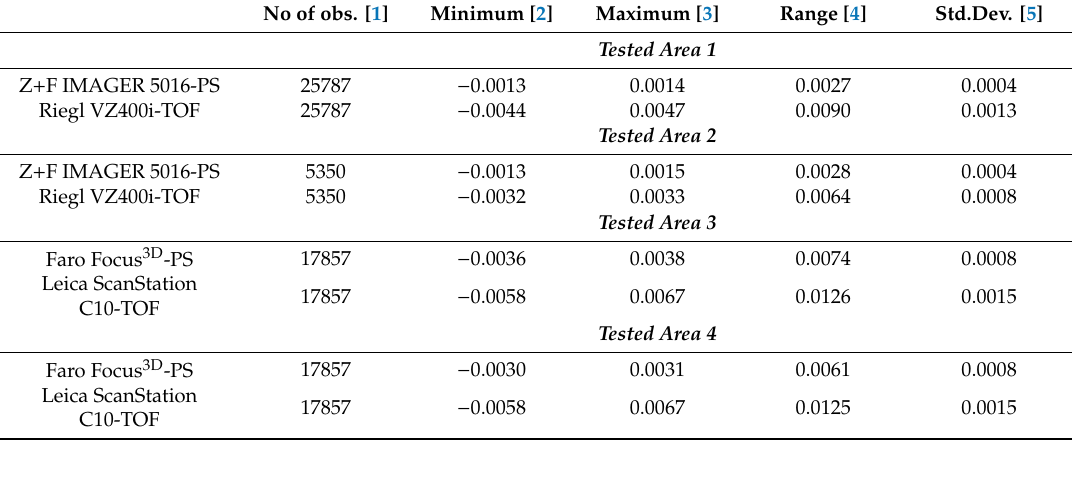
Table 3. Errors of the distance measurement of the time-of-flight (TOF) and phase-shift (PS) scanners basic statistics.